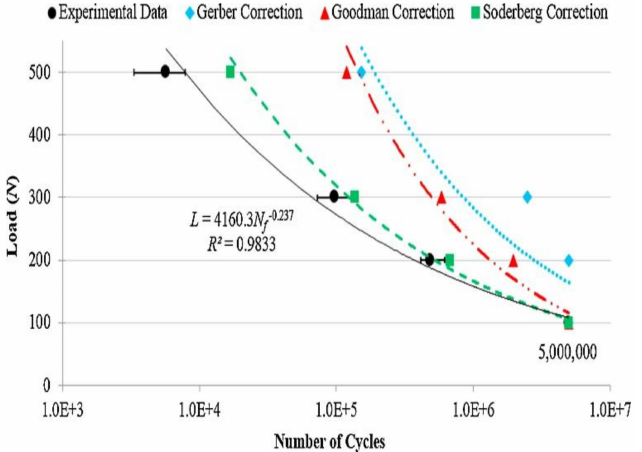
Figure 30. The results of the load-lifetime plotted for the four levels of cyclic loads. Reprinted with permission from ref. [86]. 2021,